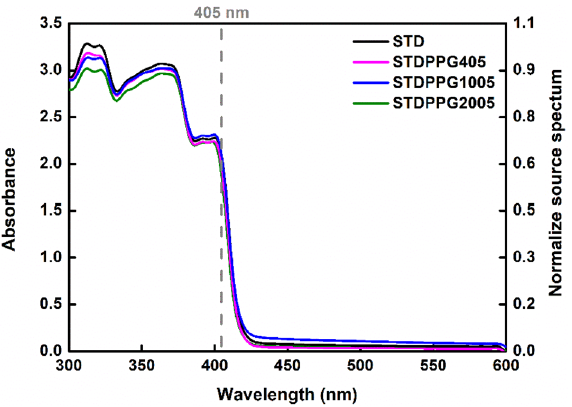
Figure 1. UV absorbance of UV-curable acrylate-based resin (STD) and the formulated resin with PPG400, PPG1000 and PPG2000 at 5%vol